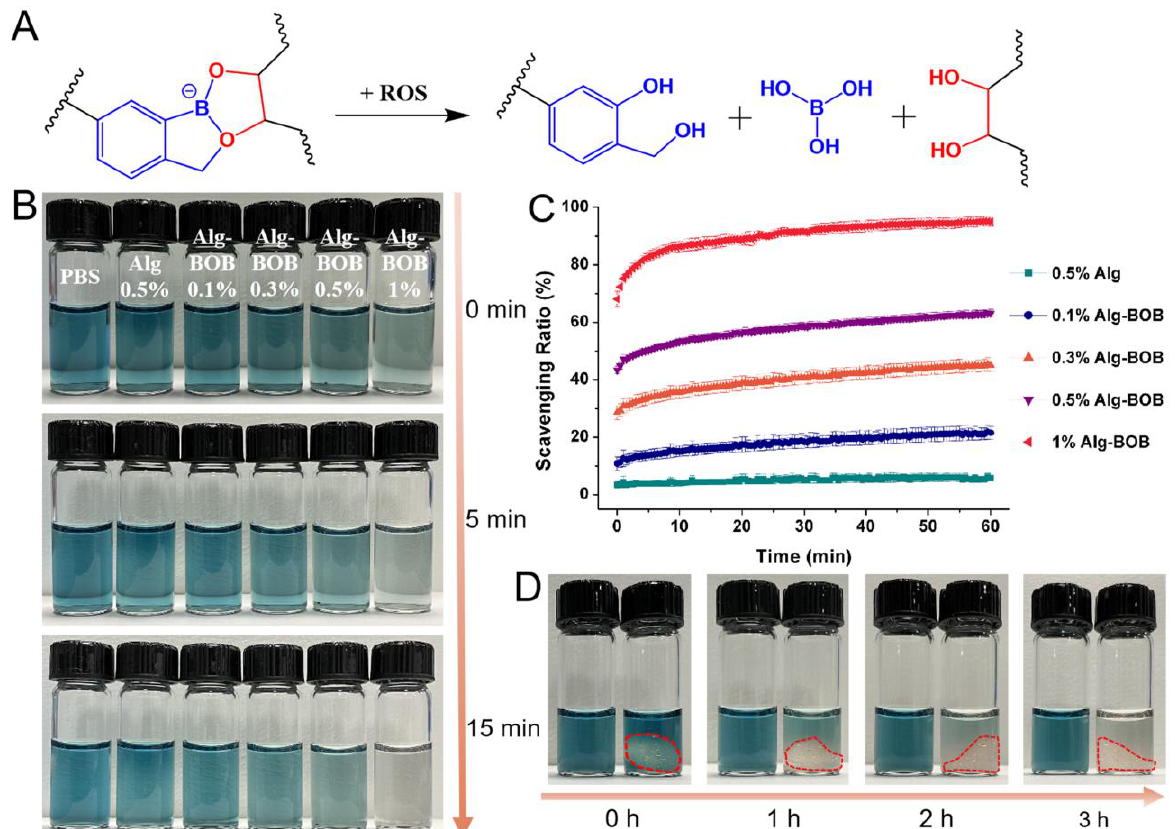
Figure 4. ( A ) Schematic illustration of the ROS responsive degradation of BOB-diol complexation.